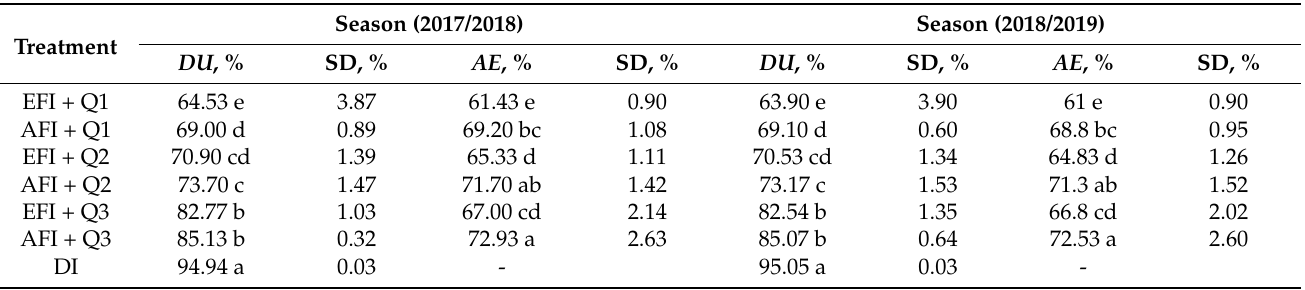
Table 2. Effect of irrigation method (EFI, AFI, and DI) and flow rate (0.47 (Q1), 0.95 (Q2), and 1.43 L/s (Q3)) on the distribution uniformity ( DU ) and application efficiency ( AE ) of water in the first and second growing seasons.